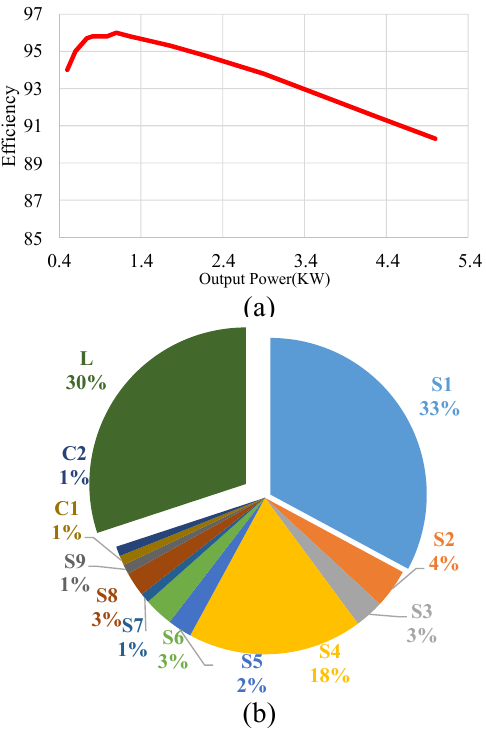
Figure 6. ( a ) Efficiency curve; ( b ) loss distribution among power components.